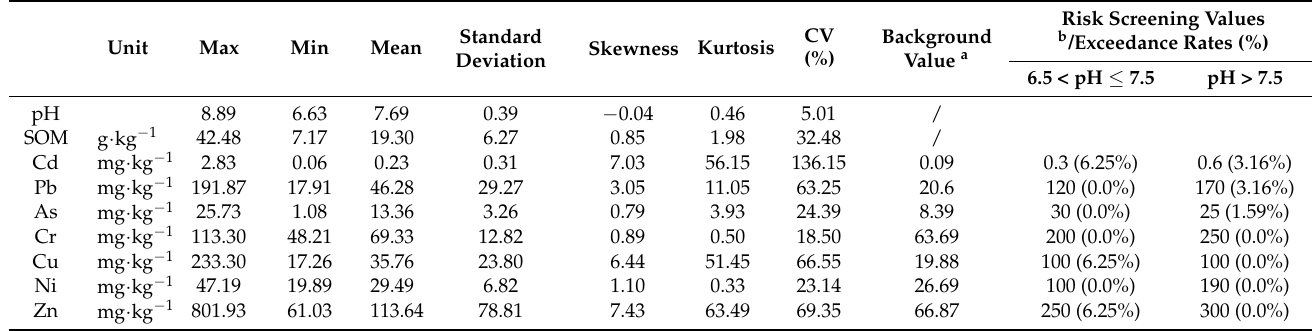
Table 2. Statistical results of soil properties and HMs concentrations ( n =